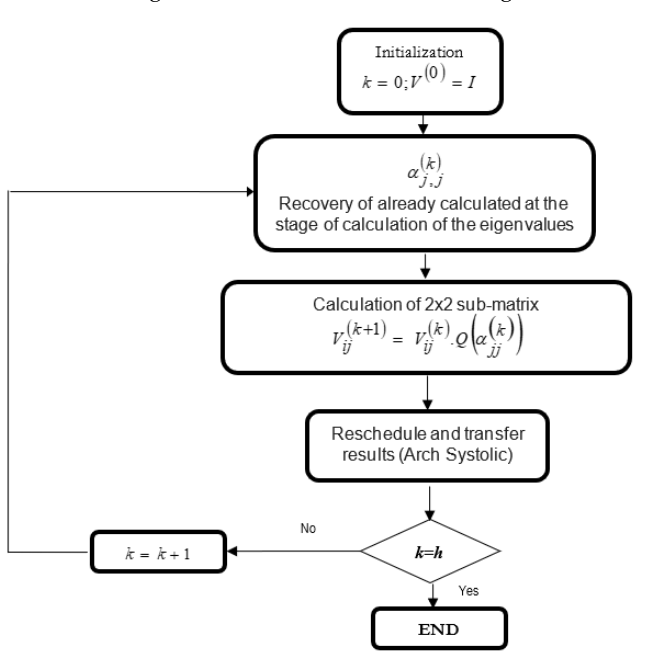
Figure 7. Flowchart for calculating eigenvectors using 2 × 2 sub-matrices of elements based on Jacobi’s method.